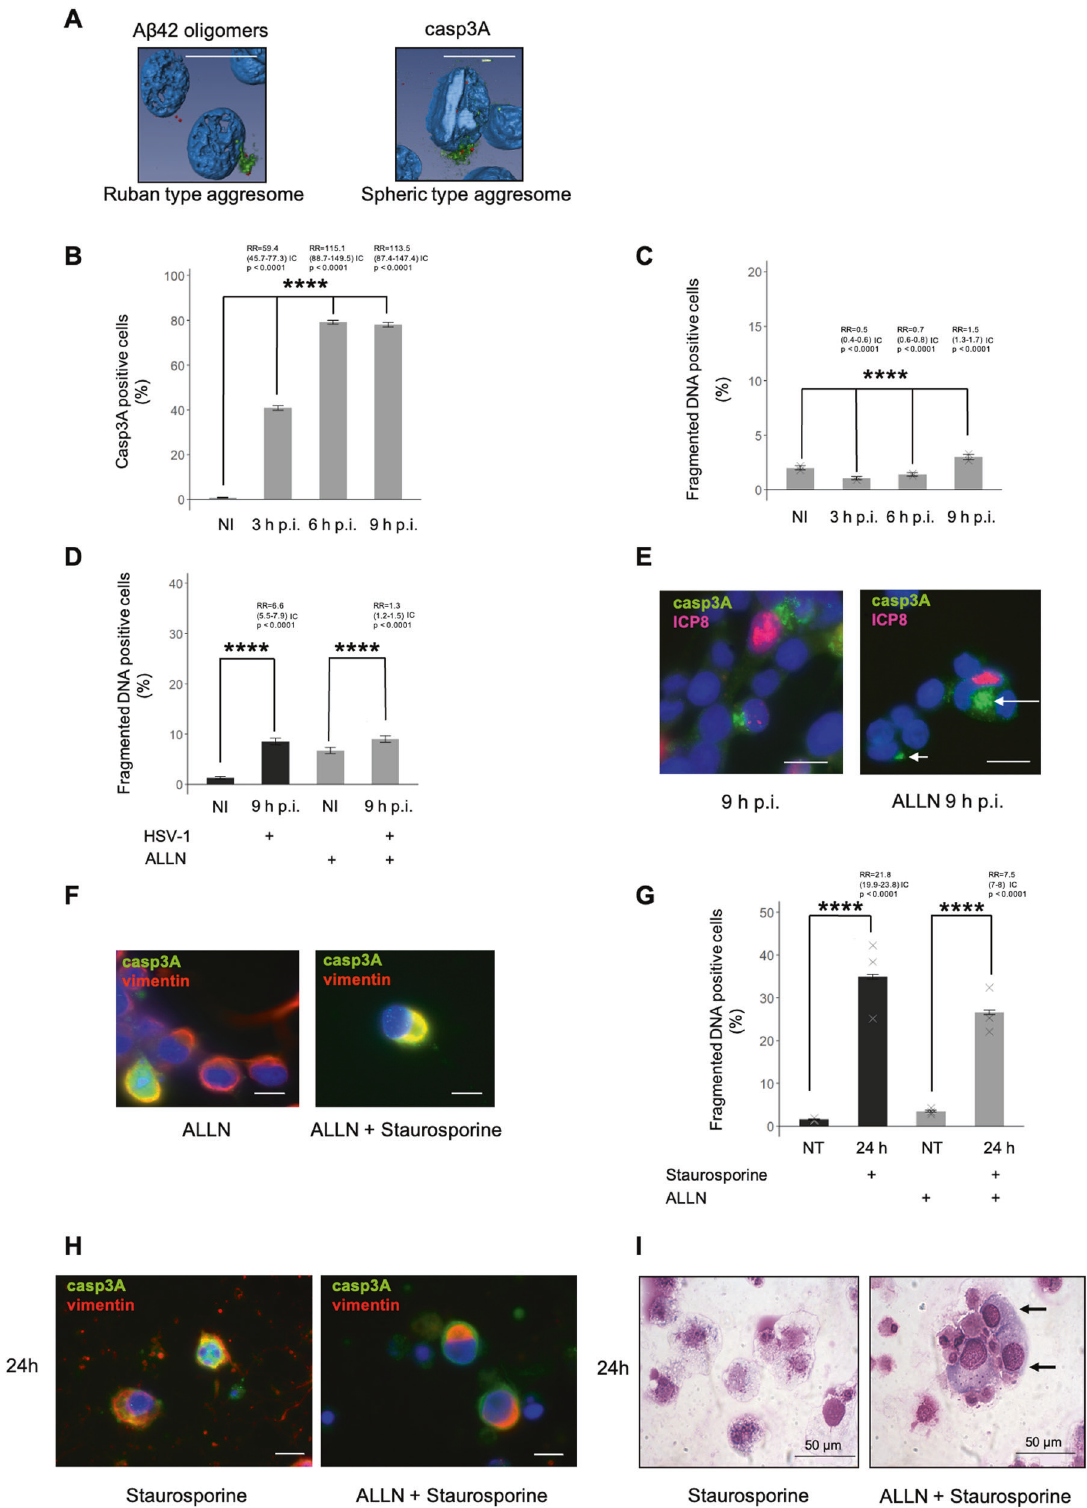
5I (black arrows – right panel). In addition, the observation that the percentage of cells in early stage of apoptosis (annexin V positive cells) was higher after staurosporine treatment in cells pre-treated with ALLN than in cells non pre-treated (not shown) supported the notion that aggresome formation inhibits